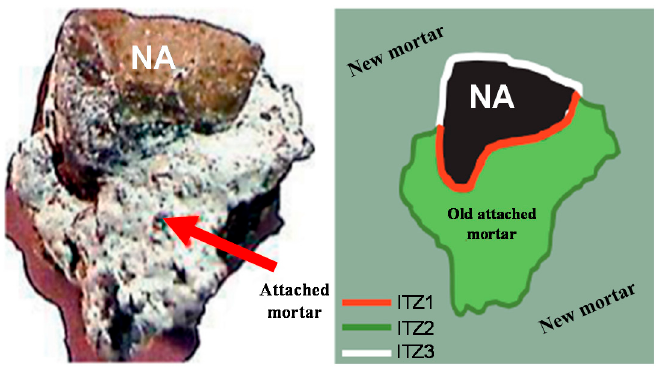
Figure 7 divides recycled aggregate concrete into three transition zones [29]: (1) the transition zone between the recycled aggregate and the old mortar stuck to the recycled